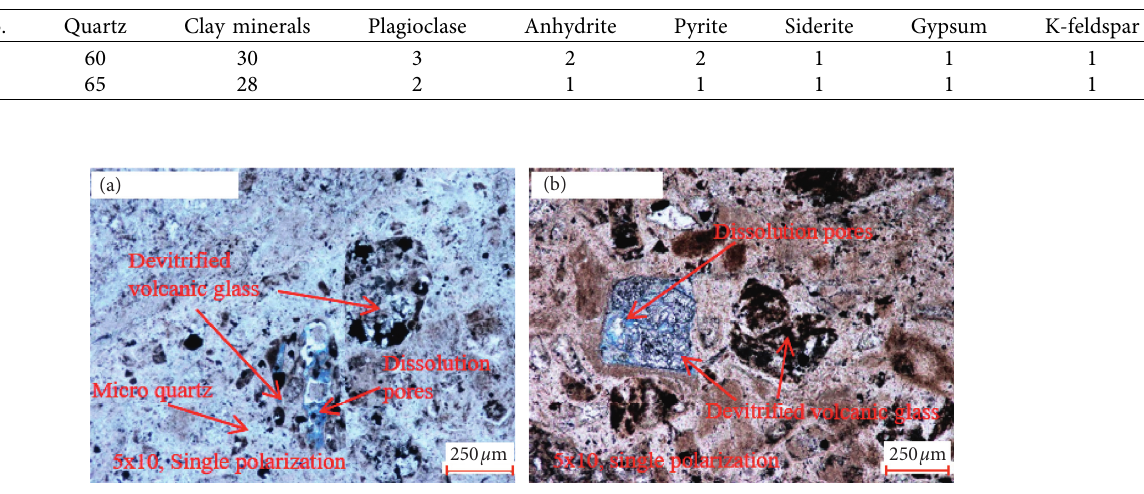
Table 1: Mineralogical composition of the tested tuff samples (weight %).